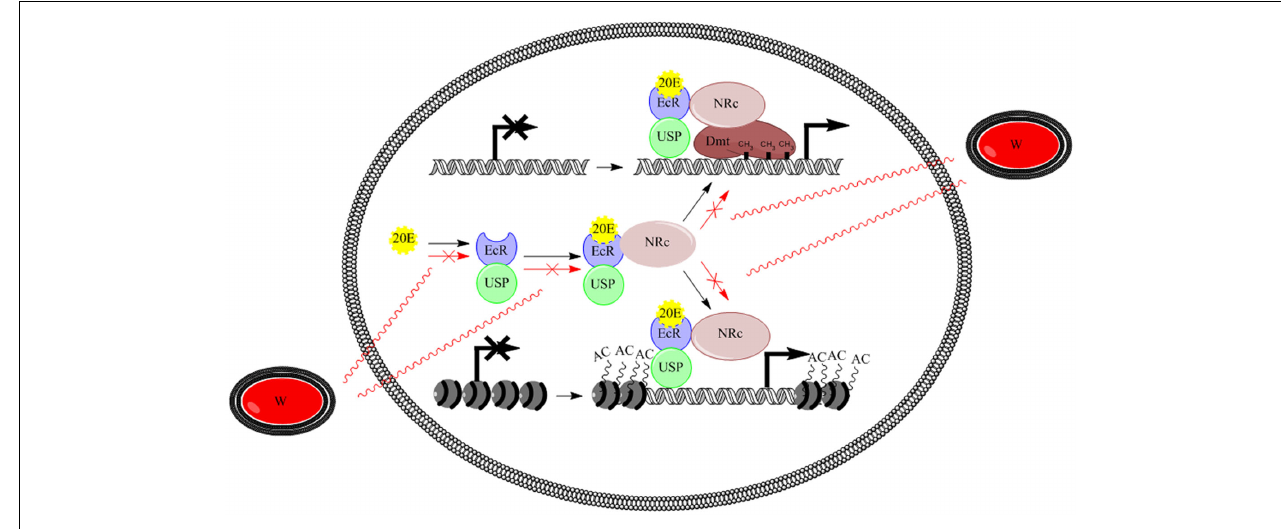
modifying enzymes, thus activating proper selective transcriptional programs. Wolbachia may interact by synthesizing products competing with 20E or function as/interfere with nuclear receptor co-regulators, respectively. 20E, 20-hydroxyecdysone; EcR, ecdysone receptor; USP, ultraspiracle; NRc, nuclear receptor co-regulator; Dmt, DNA-methyltransferase;W, Wolbachia